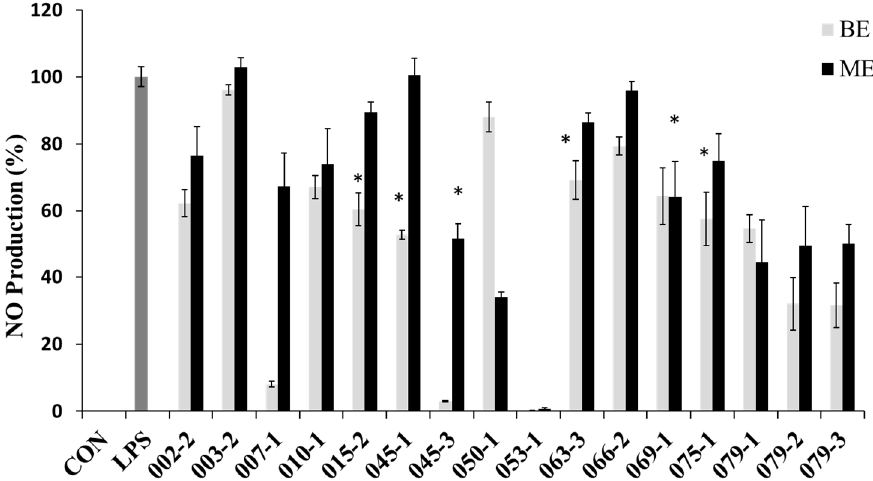
Figure 2. Nitric oxide (NO) production inhibitory effects of the extracts from marine-derived fungi. Each value indicates the mean ± S.D. and is representative of results obtained from three independent experiment. * p < 0.05 indicates significant differences from the LPS-stimulated group.